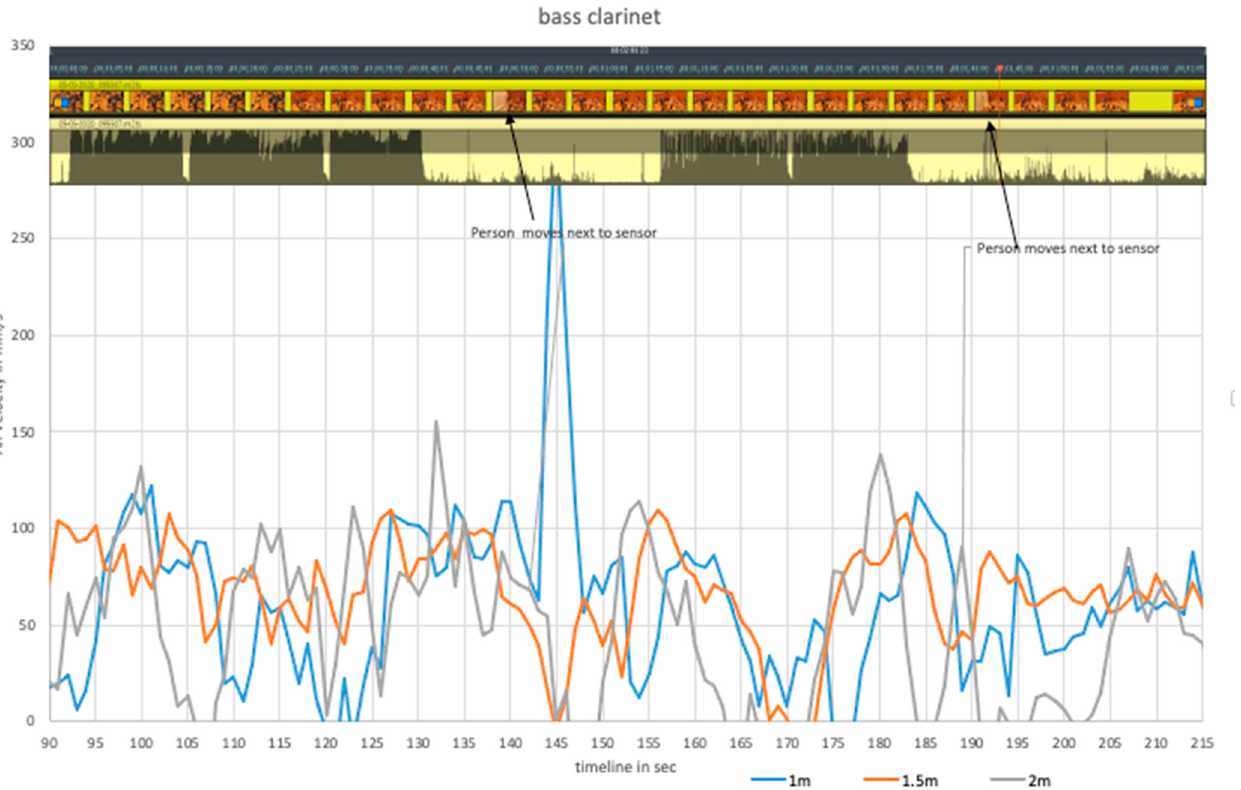
Figure A9. Artificial fog at the labium of the recorder.